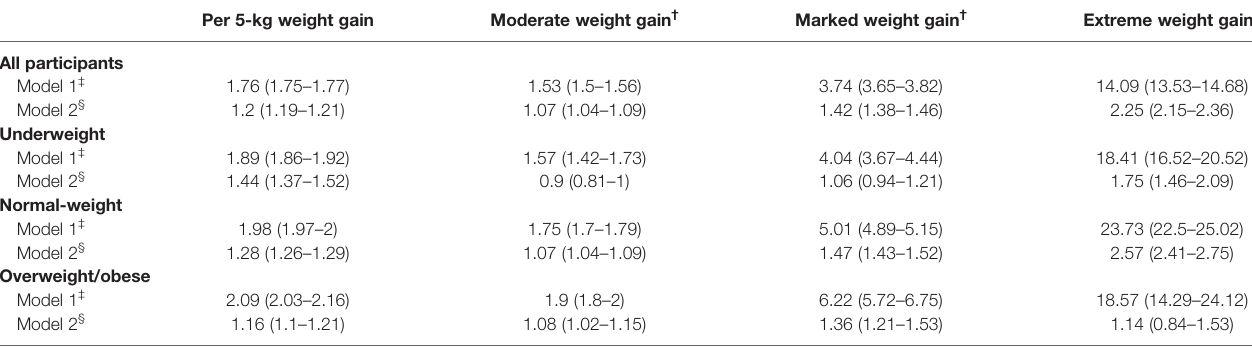
TABLE 3 | Odds ratios of metabolic disorder* associated with weight gain from young to middle adulthood by overall and BMI categories at young